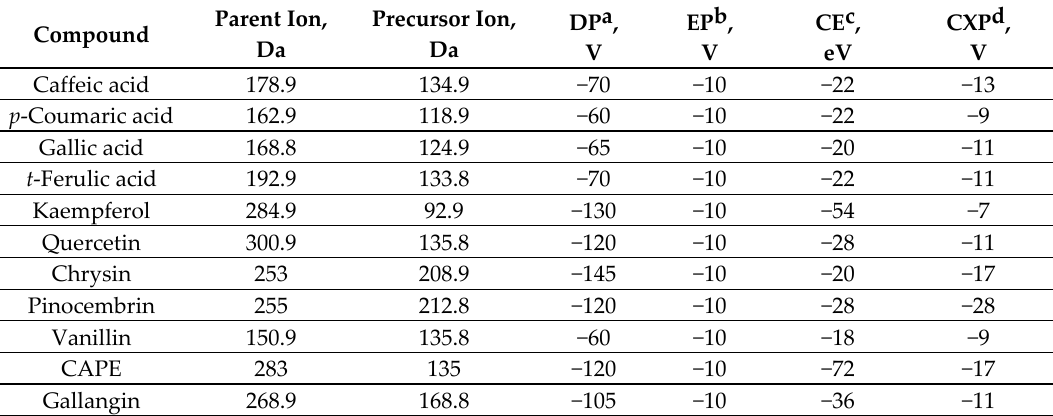
Table 1. MS experimental characteristics of the investigated compounds.